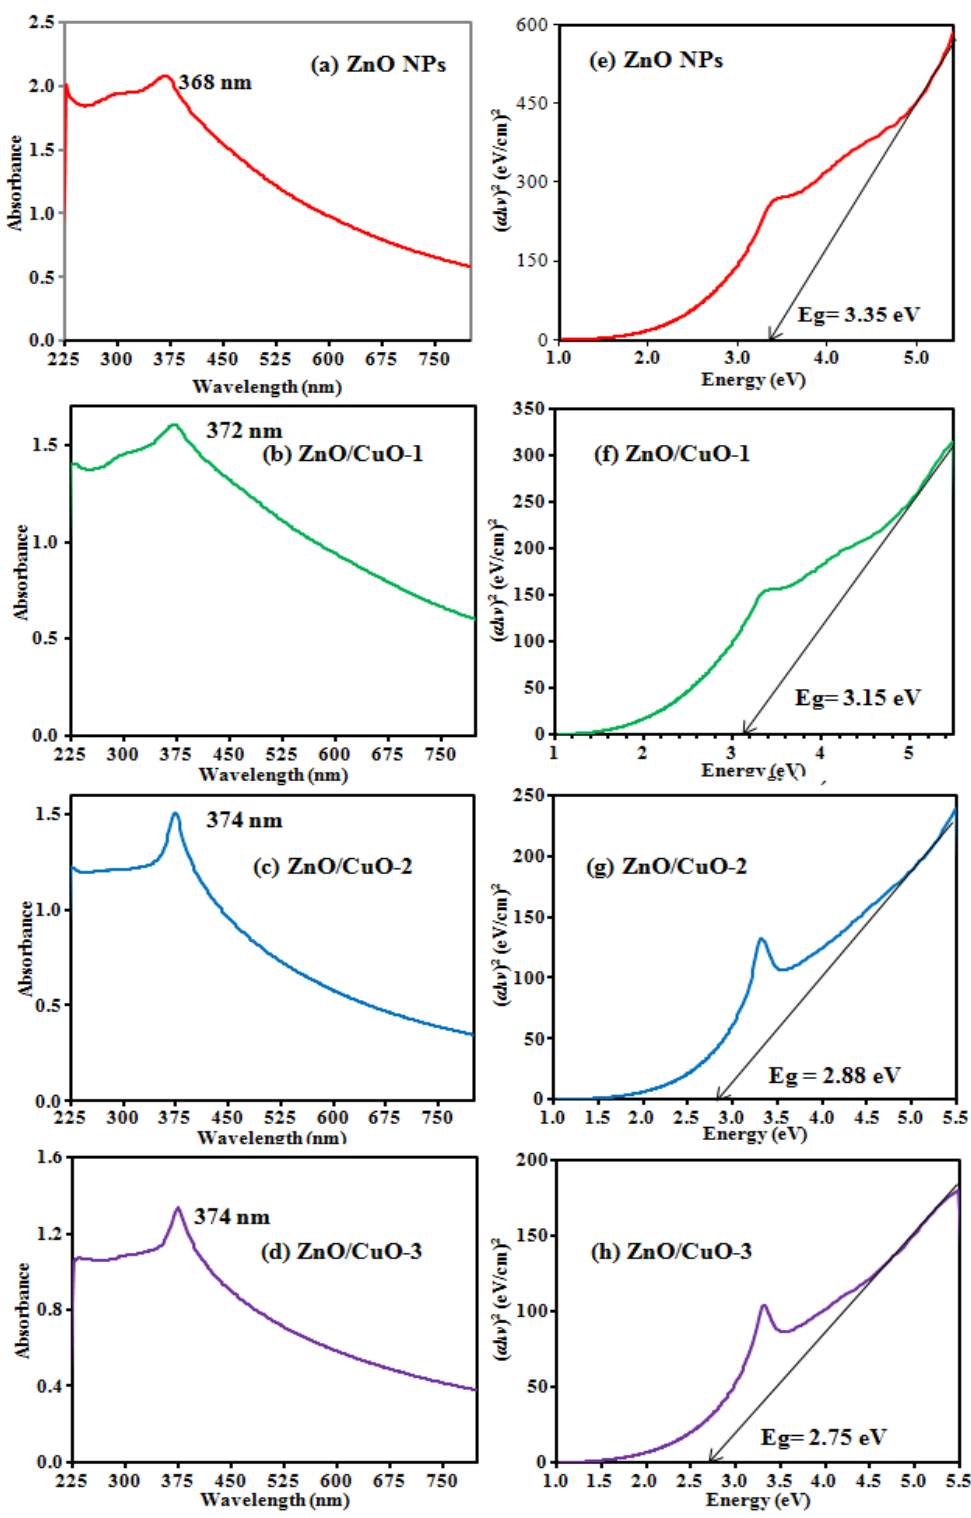
Fig.6. UV-visible absorption spectra of (a) ZnO nanoparticles and (b) to (d) ZnO/CuO nanocomposites and Tauc plots for (e) ZnO NPs and (f) to ( h) ZnO/CuO